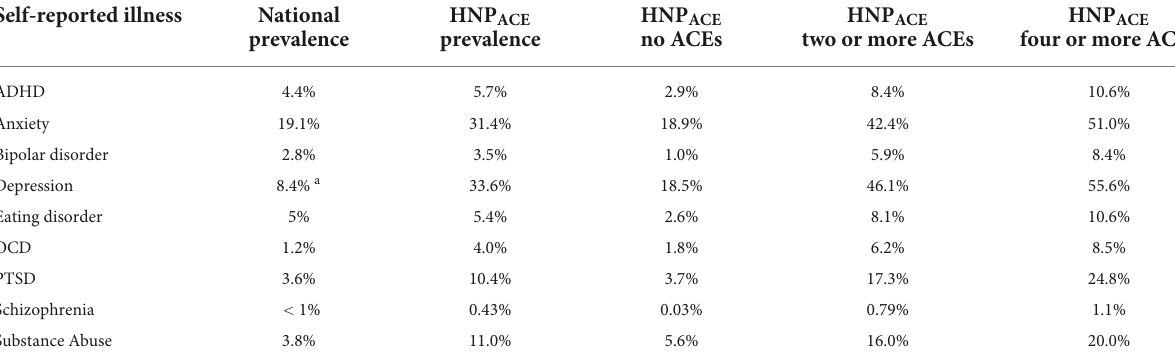
TABLE 2 Self-reported mental illness prevalence in the HNP ACE